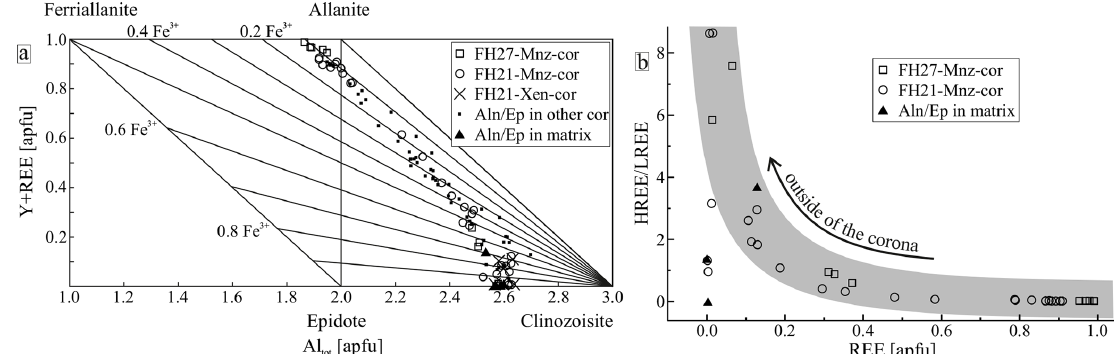
Figure 8. Chemical composition of REE-bearing epidote-group minerals. (a) REE + Y vs. Al tot diagram (following Petrík et al., 1995) and (b) in a REE-composition diagram. The data for grains from other coronae come from the samples listed in Table 1. Similarly, epidote-group minerals from the pegmatite’s matrix come from all five samples (Table 1; in the following we use the abbreviation cor for corona).